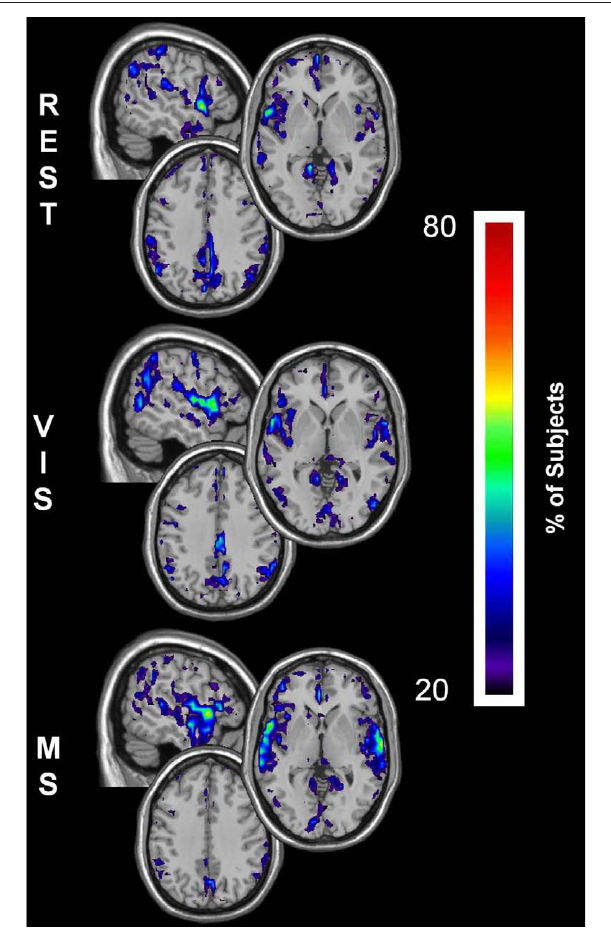
Figure 6 | Local efficiency overlay maps during rest, visual, and multisensory tasks. In each subject the voxels with local efficiency values in the top 15% were identified. These maps represent the overlap of these voxels across subjects in each of the three tasks. The consistency of overlap across subjects is indicated by the threshold color bar that represents the percentage of individuals. E maps show that at rest (REST) the visual and loc parietal cortices have the greatest clustering. Regions of high clustering shift during the visual task (VIS) to the visual cortex and to both the visual and auditory cortex during the multisensory task (MS). A progressive decrease in the local efficiency in the parietal cortex was observed across the three tasks.